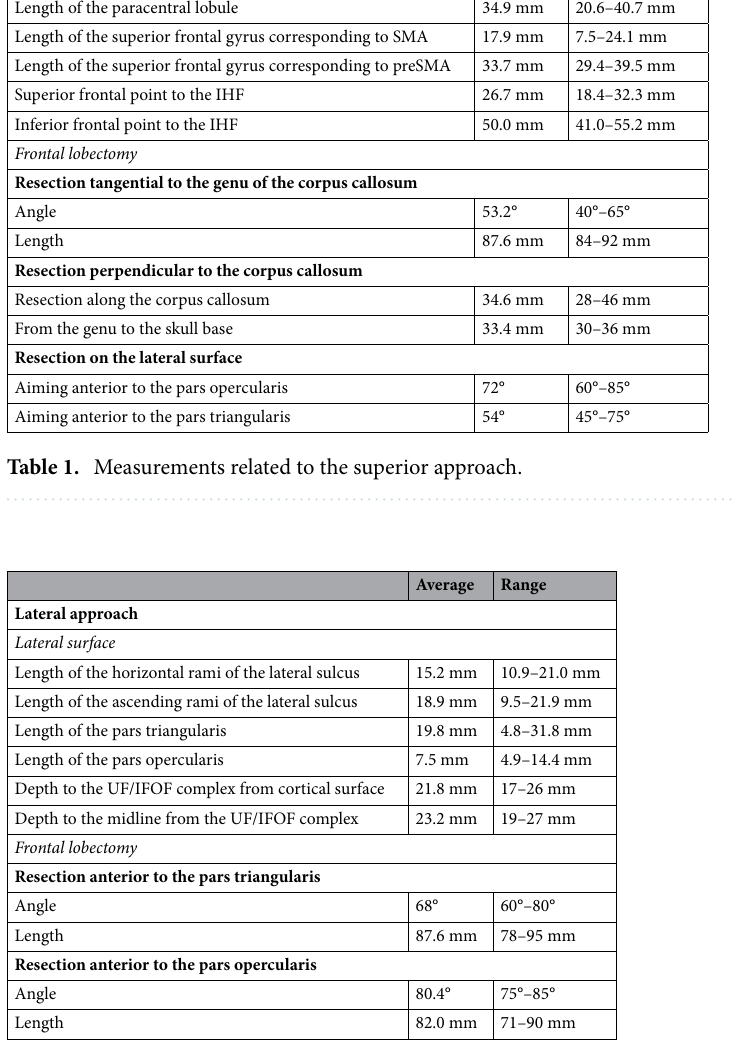
Table 2. Measurements related to the lateral